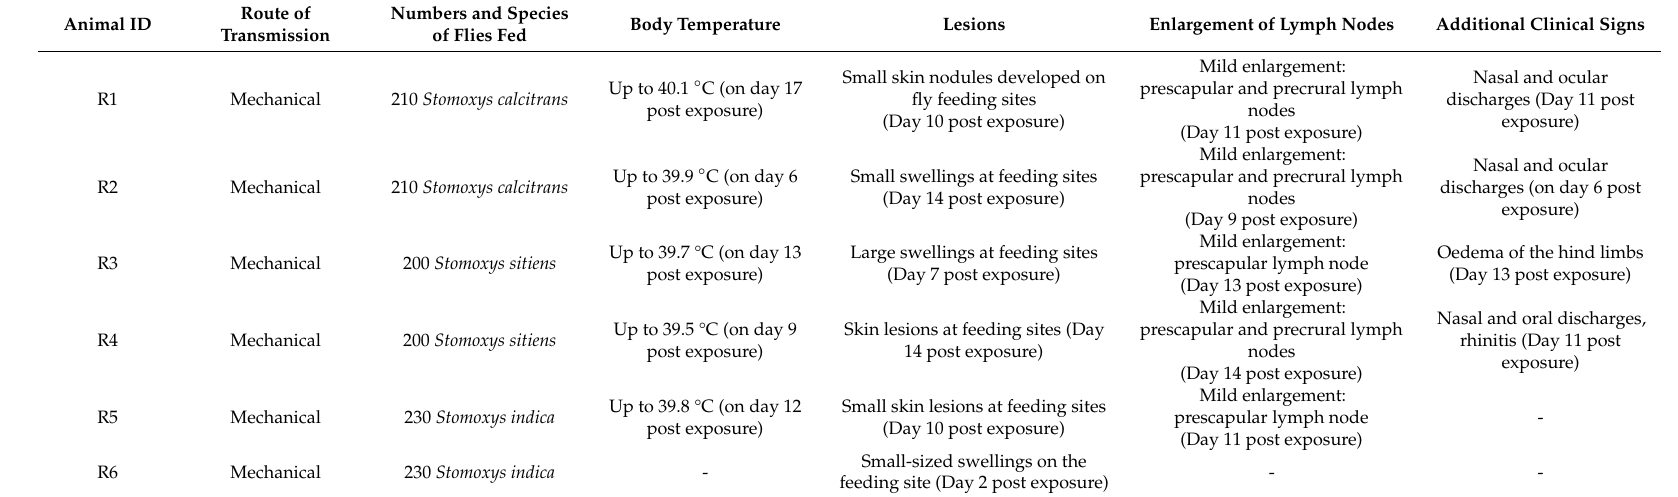
Table 2. Clinical manifestations of LSD for recipient animals infected through transmission of LSDV by Stomoxys